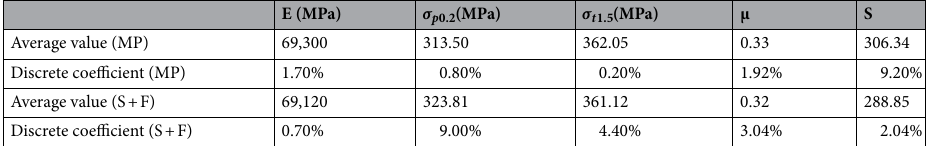
Table 1. Basic mechanical property parameters test results. PS: E is tensile modulus, σ p 0.2 is yield strength,